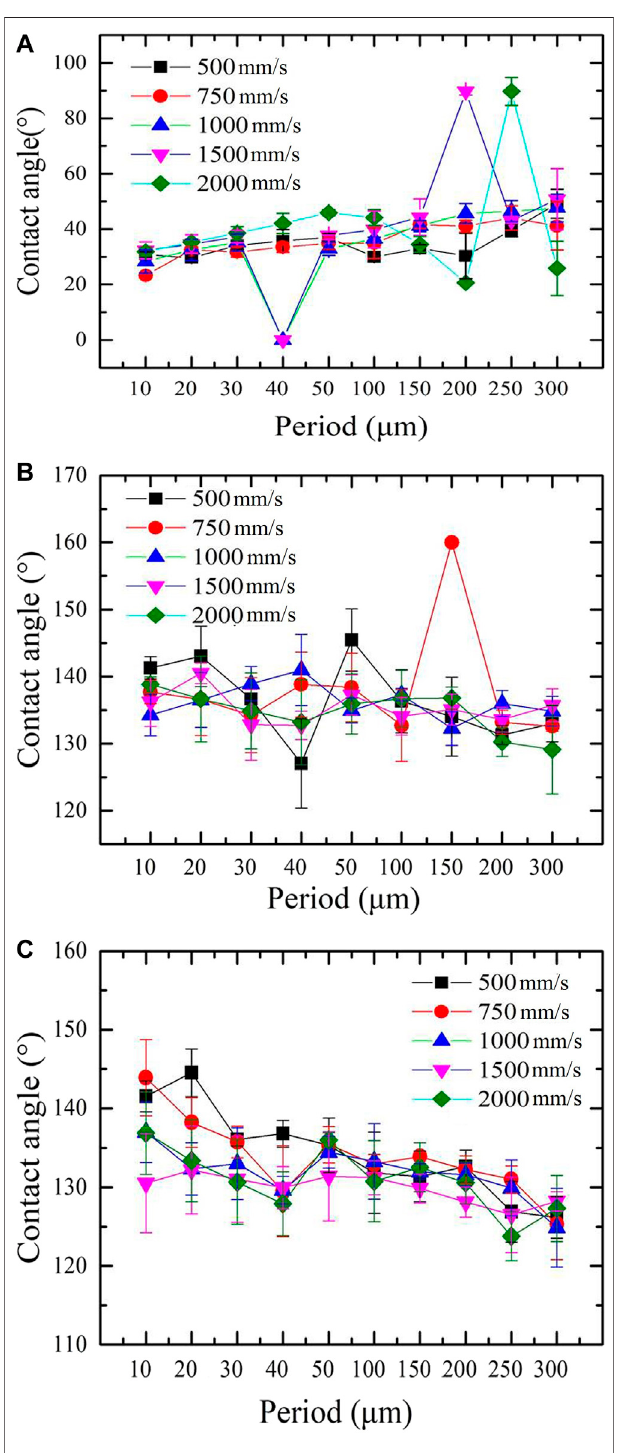
FIGURE 2 | CAfor differenttreated samples. (A) After laser treatment. (B) After laserandchemicaltreatment. (C) Afterlasertreatmentcombinedwiththermaloxidation.